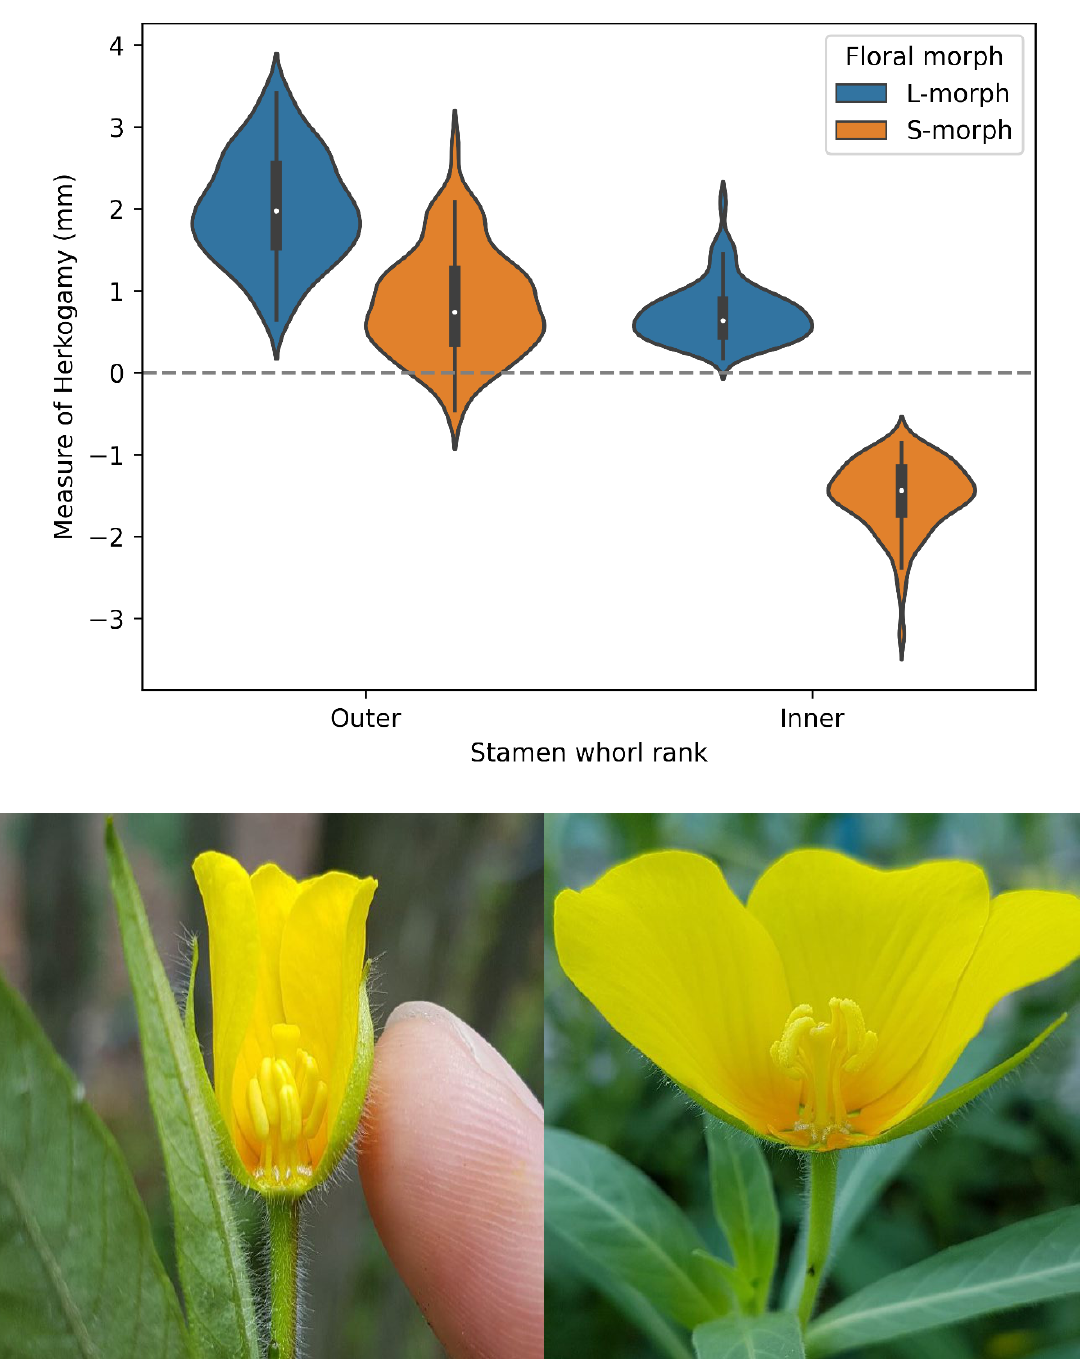
Figure S1: Measures and photos of herkogamy in self-incompatible L-morph and self-compatible S- morph flowers found in Western European populations of Lgh. Measures are reported for the outer and inner whorls of anthers. 150 measured flowers per violin plot, 5 populations sampled across the Loire watershed per